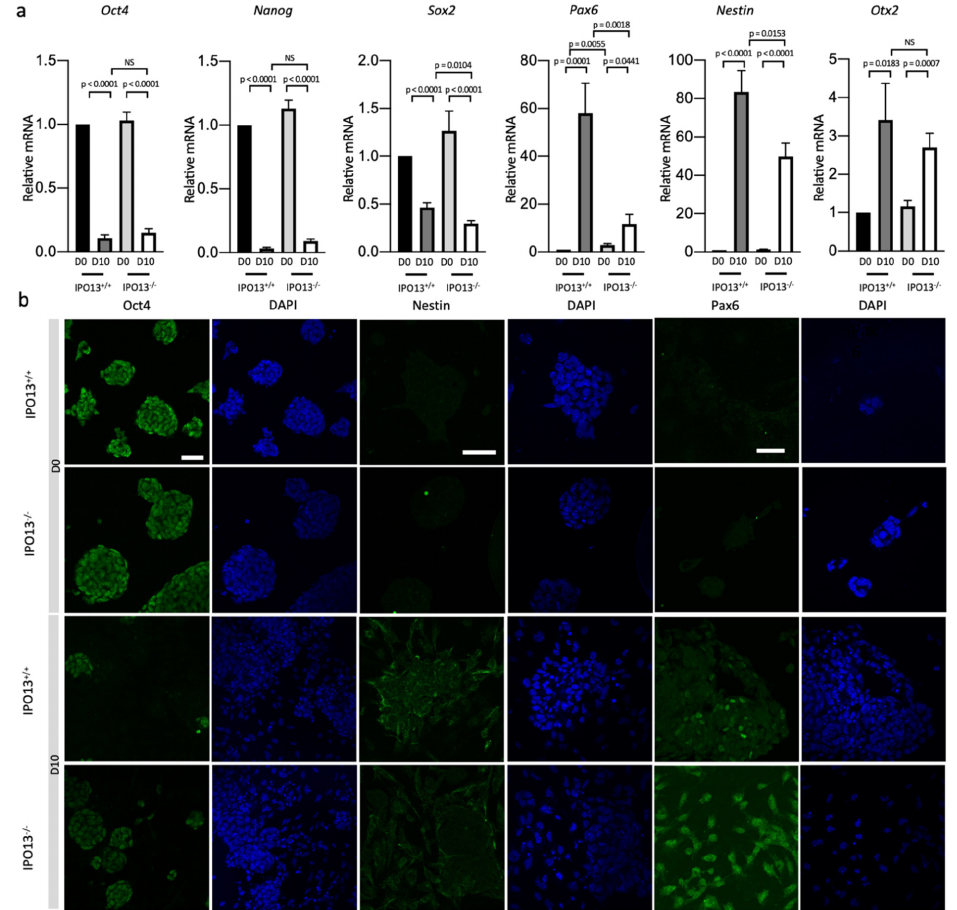
Figure 2. Expressions of neural progenitor markers Pax6 and Nestin were reduced in differentiated IPO13 − / − cells. IPO13 +/+ and IPO13 − / − mESCs were induced to differentiate as in Figure 1. ( a ) RNA was extracted from IPO13 +/+ and IPO13 − / − mESC at differentiations D0 and D10. Transcript levels were assessed using SensiMix SYBR Green. Results for gene expression were normalised to the expression of housekeeping genes Sdha , Tbp , and 18s . Data were relativised to IPO13 +/+ D0 expression values. Results represent the mean ± SEM ( n = 7, where each cDNA sample was